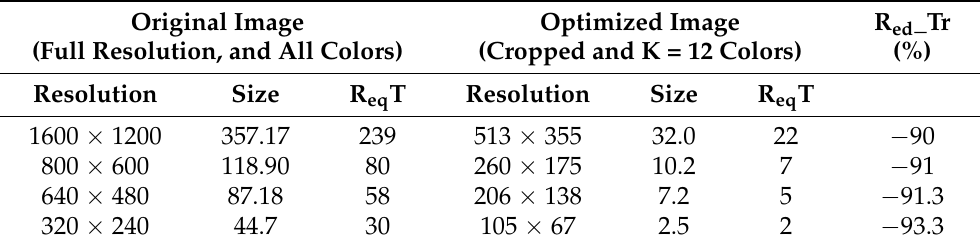
Table 5. Reduced numbers of transmissions for transmitting an optimized image with K = 12 colors in contrast to transmitting an original with K = all colors given in kB.